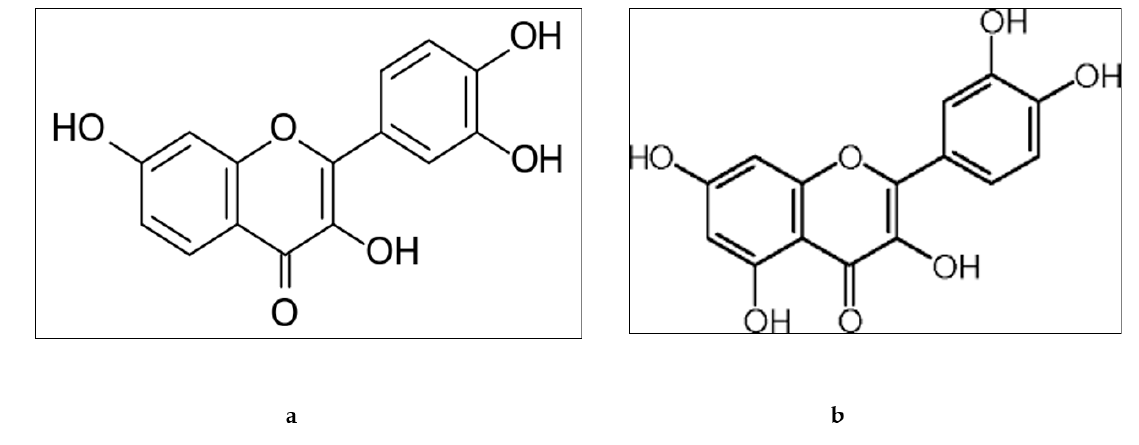
Figure 3. Chemical structure of fisetin ( a ) and quercetin ( b ).